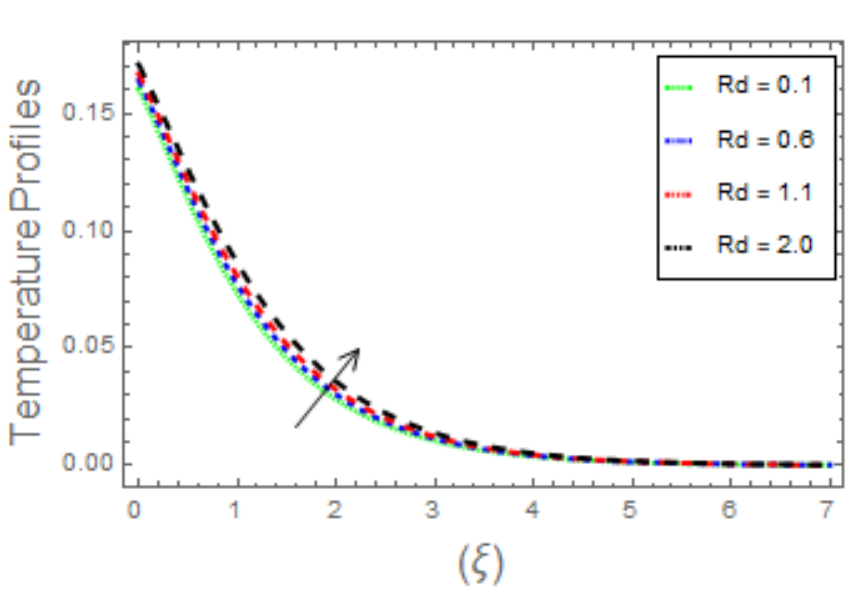
Figure 8. Variation in f (cid:48) ( ξ ) due to N .